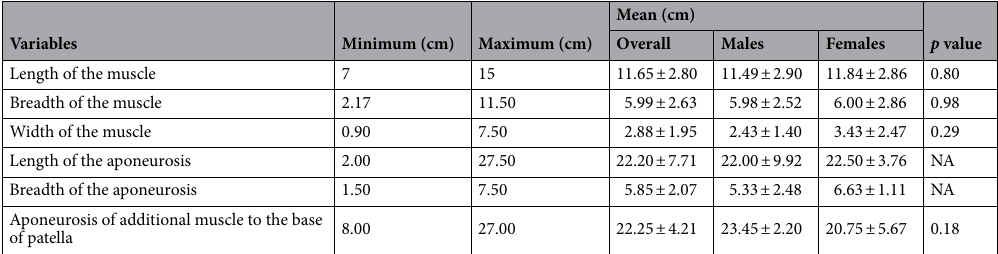
Table 1. Comparison of the mean of variables in cadaveric males and females.